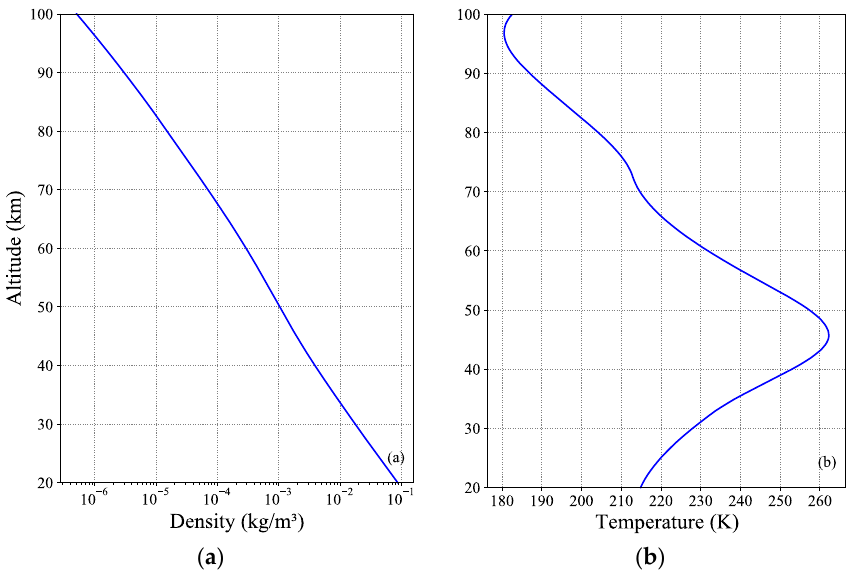
Figure 3. ( a ) Atmospheric density and ( b ) temperature profile provided by the NRLMSISE-00 atmosphere model.